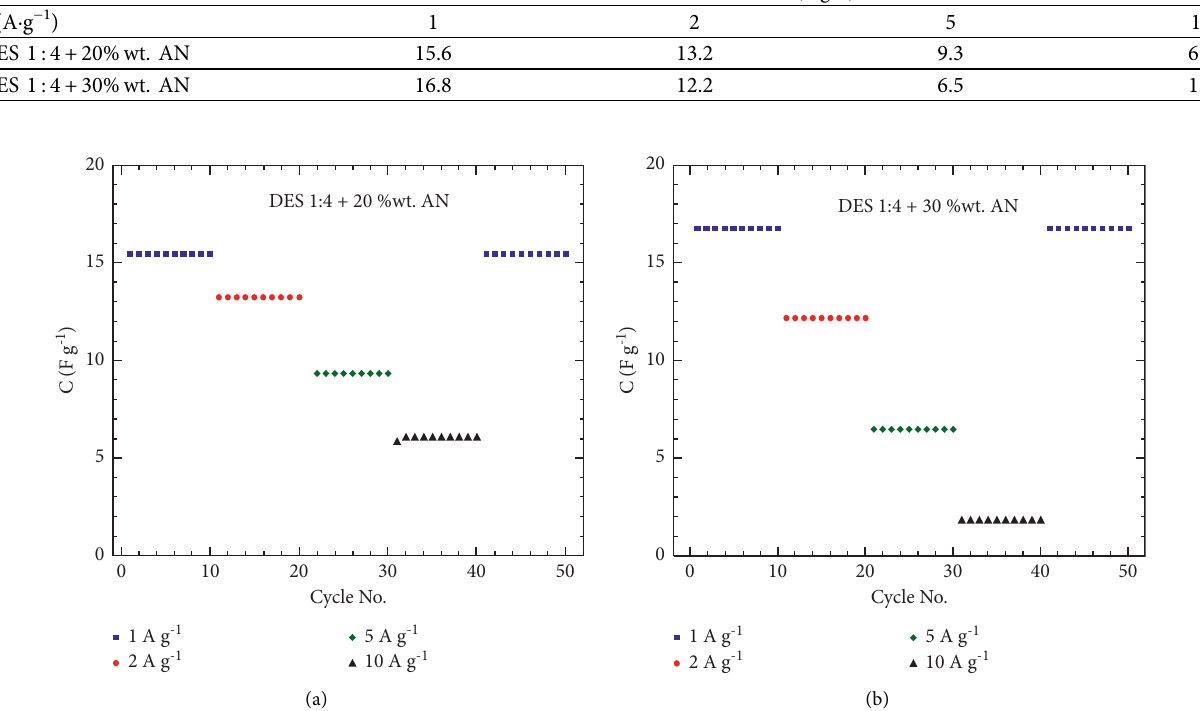
Figure 9: Specific capacitances at different current densities of (a) DES 1:4 +20%wt. AN and (b) DES 1:4 +30%wt. AN system.